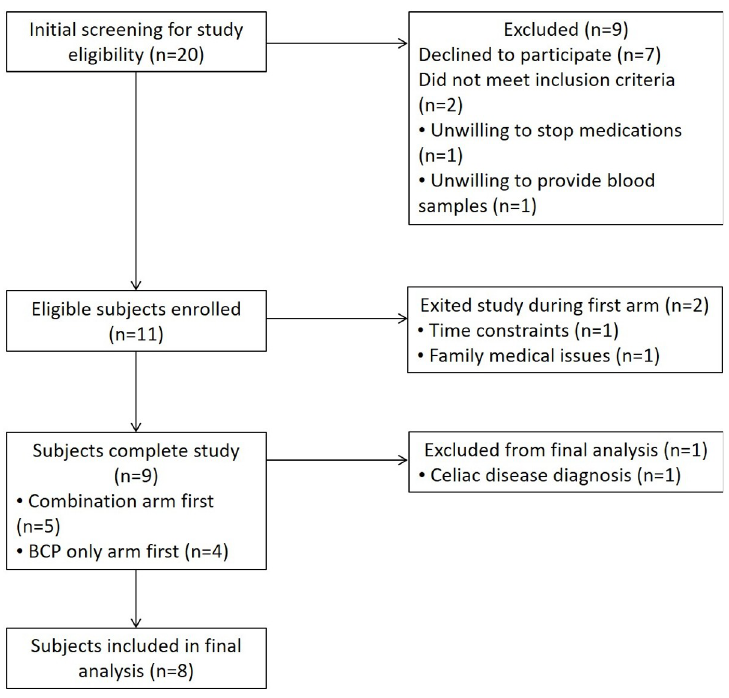
Fig 1. Study subject enrollment flow chart. Diagram describing the number of participants screened, randomized into treatment groups, screen-failed, withdrew throughout the study period and included in the final analysis.